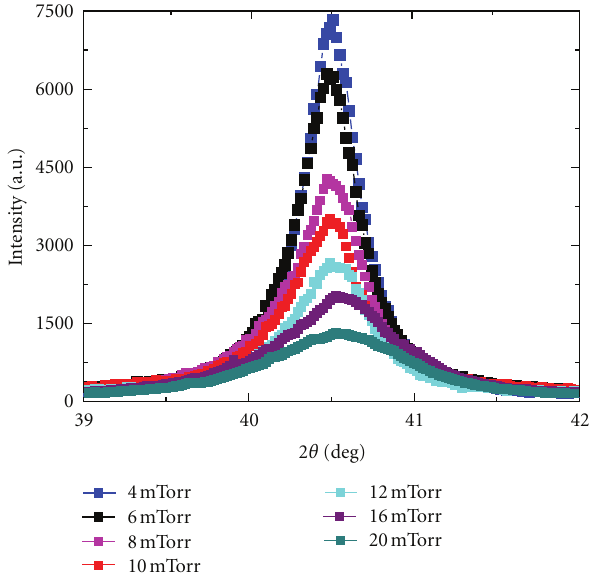
Figure 2: XRD pattern of the (110) peak for rf sputtered molybdenum thin film as a function of argon